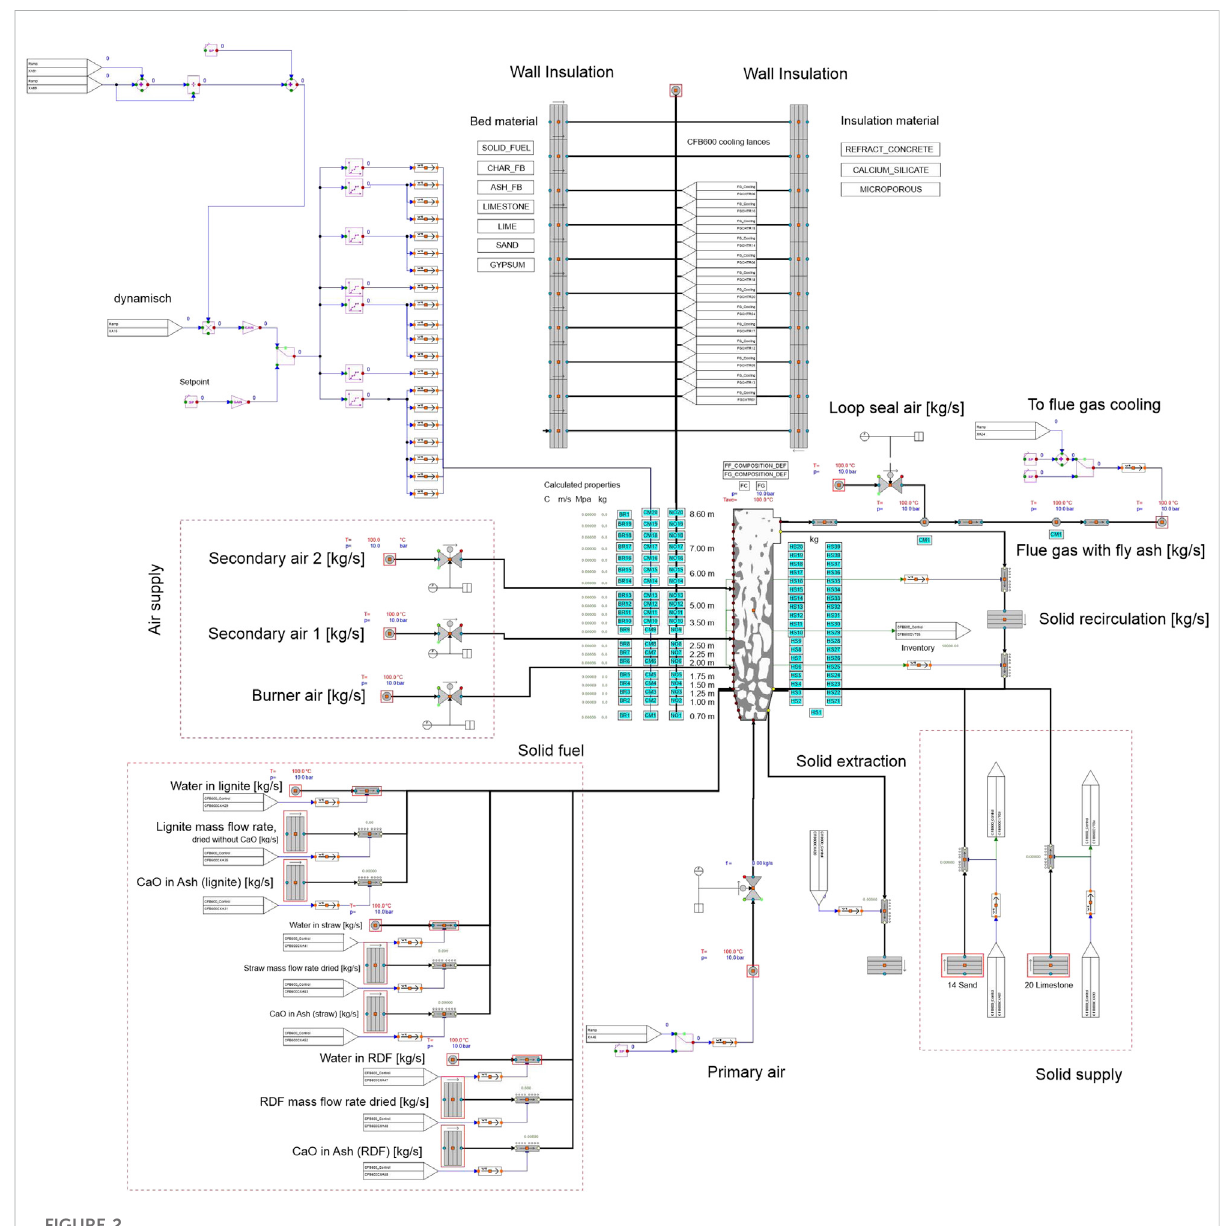
FIGURE 2 Overview of the dynamic